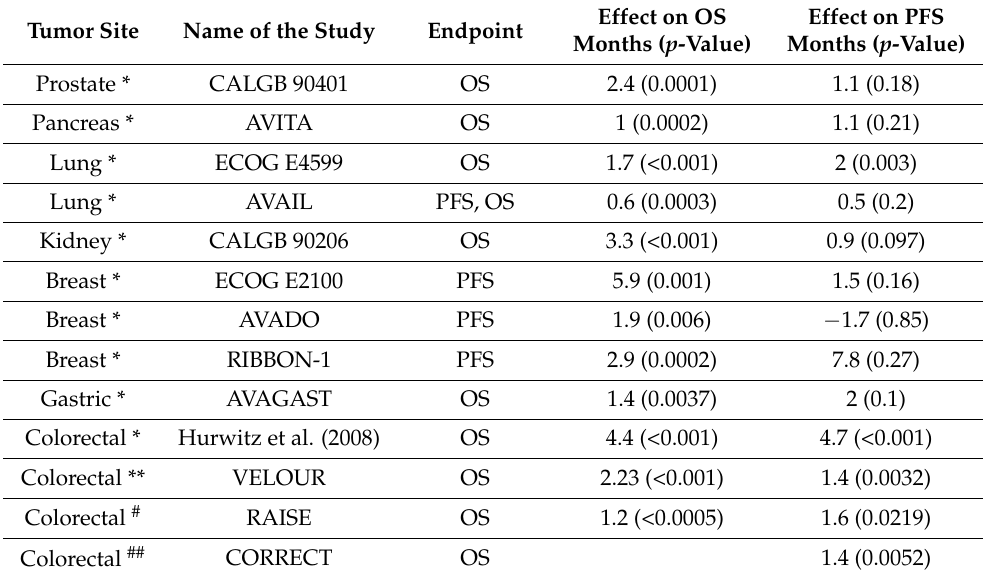
Table 1. Angiogenesis-targeting agents and their impact on survival. Tumor